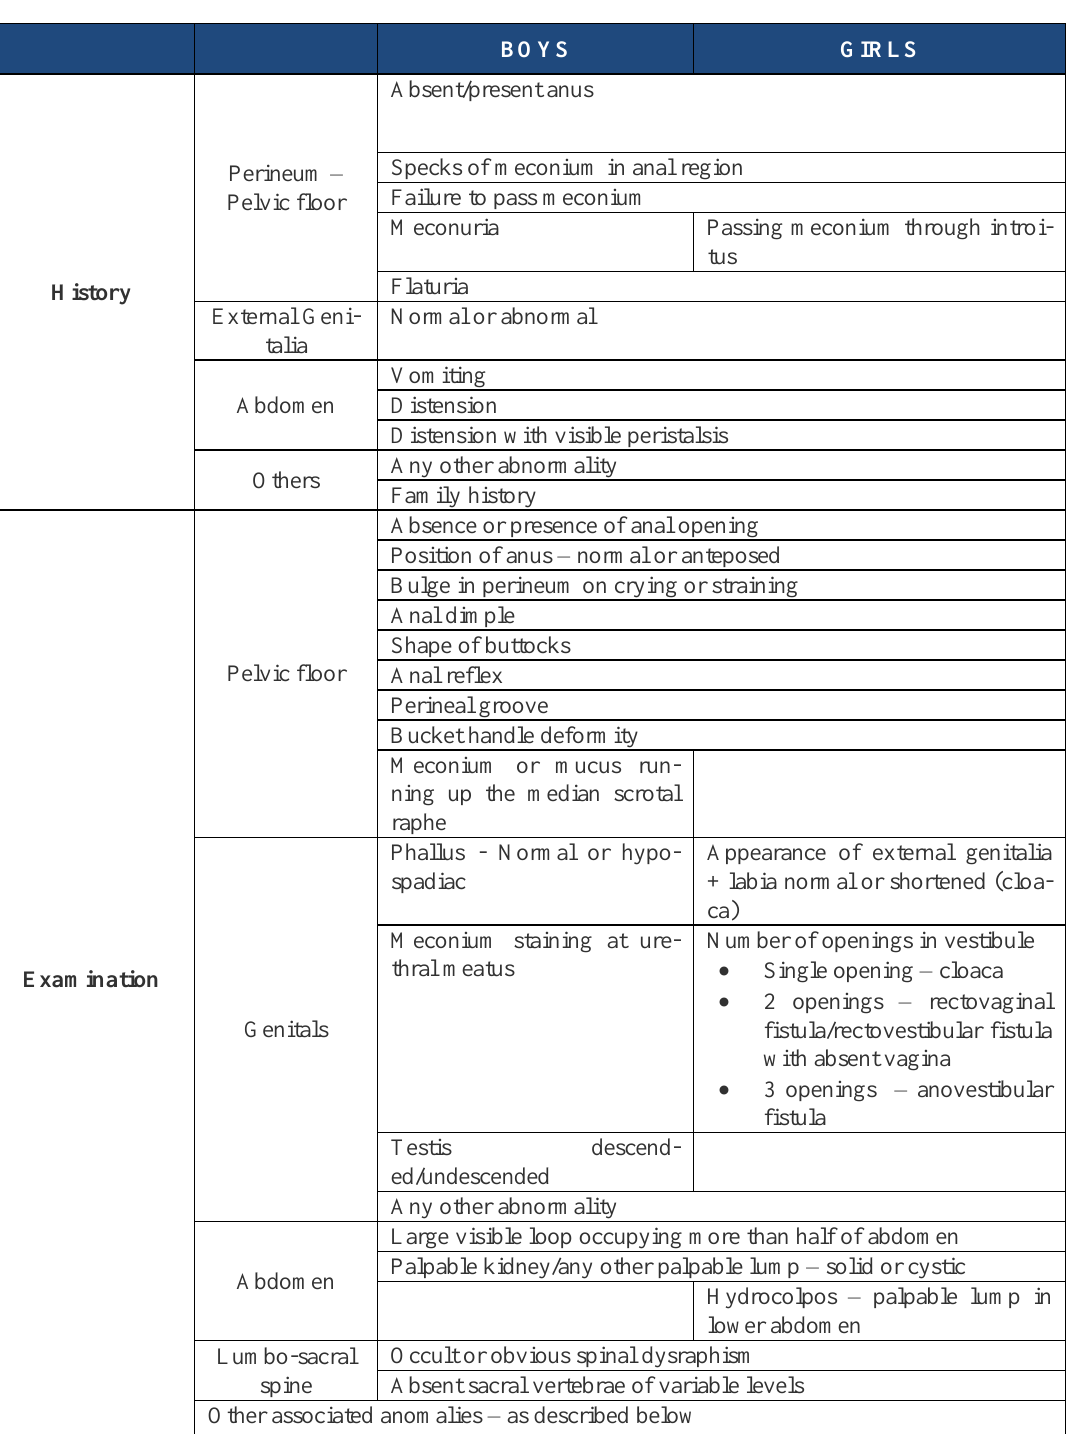
Table 5: Clinical features in ARM in newborn at birth